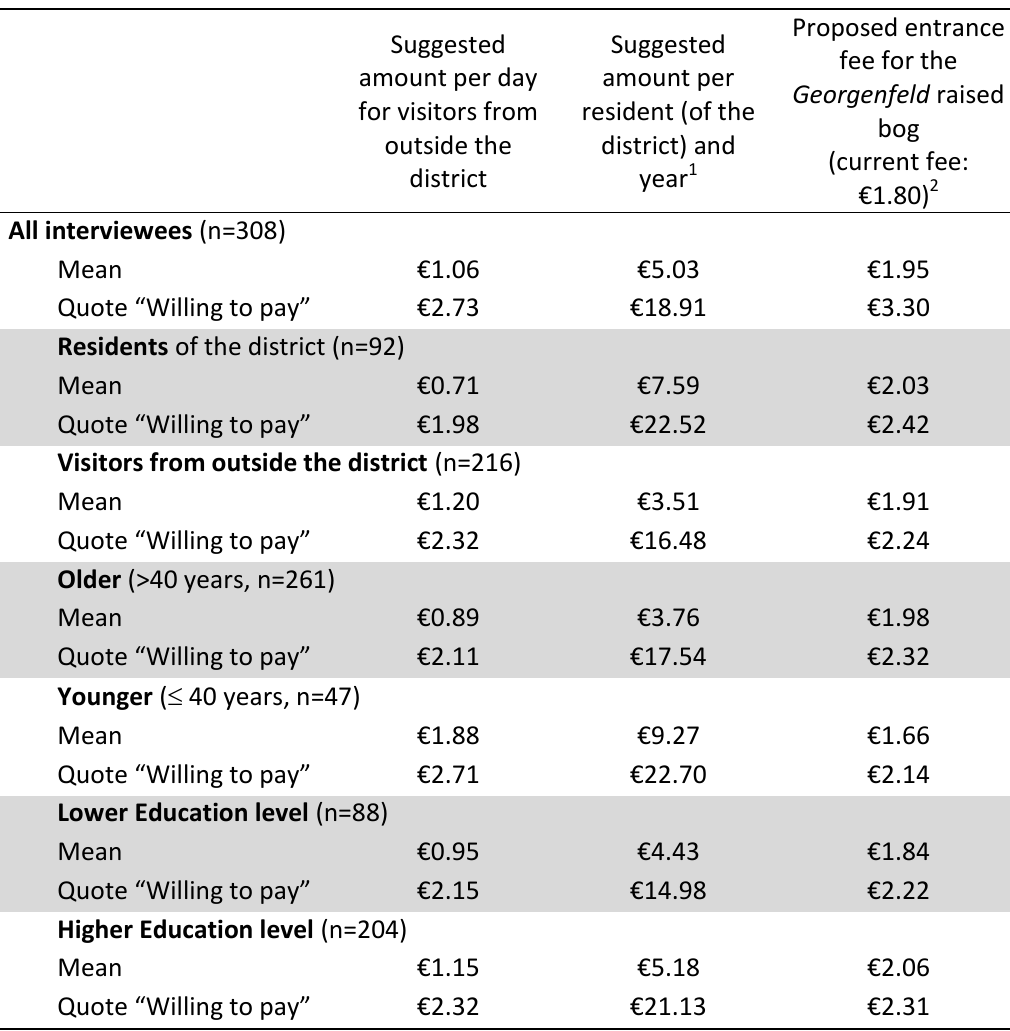
Table 4: WTP of visitors for nature conservation and landscape management (in the Eastern Ore Mountains generally and for the Georgenfeld raised